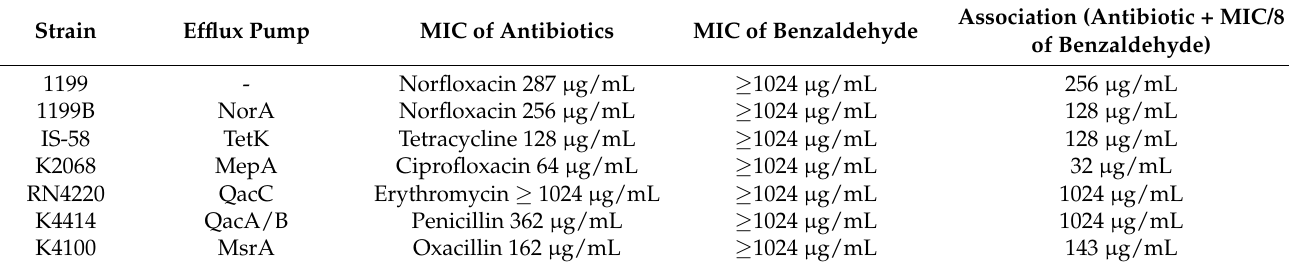
Table 1. MIC of antibiotics and benzaldehyde against Staphylococcus aureus .